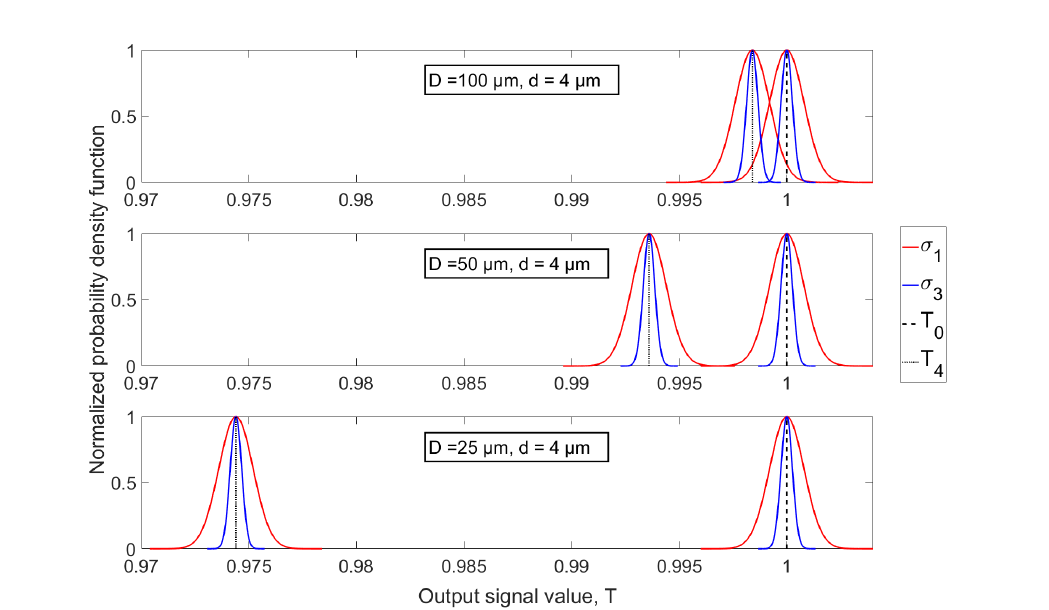
Figure 13. Probability density functions (pdfs) for noise around the two relevant signal output levels of T = 1 (denoted T 0 ) and the level corresponding to a 4µm diameter particle fully enclosed by the apertures ( T 4 ). The high ( σ 1 ) and low ( σ 3 ) noise level distributions are shown as red and blue solid curves, respectively.